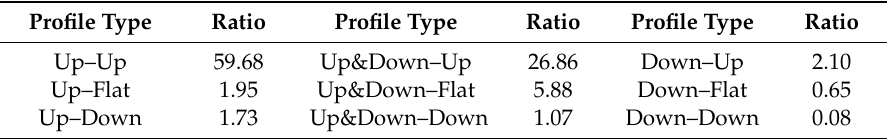
Figure 6. Dynamic resistance profiles: ( a ) Up – Up profile; ( b ) Up – Flat profile; ( c ) Up – Down profile; ( d ) Up&Down – Up profile; ( e ) Up&Down – Flat profile; ( f ) Up&Down – Down profile; ( g ) Down – Up profile; ( h ) Down – Flat profile; ( i ) Down – Down profile. Table 4. Ratios of different profile types (%).